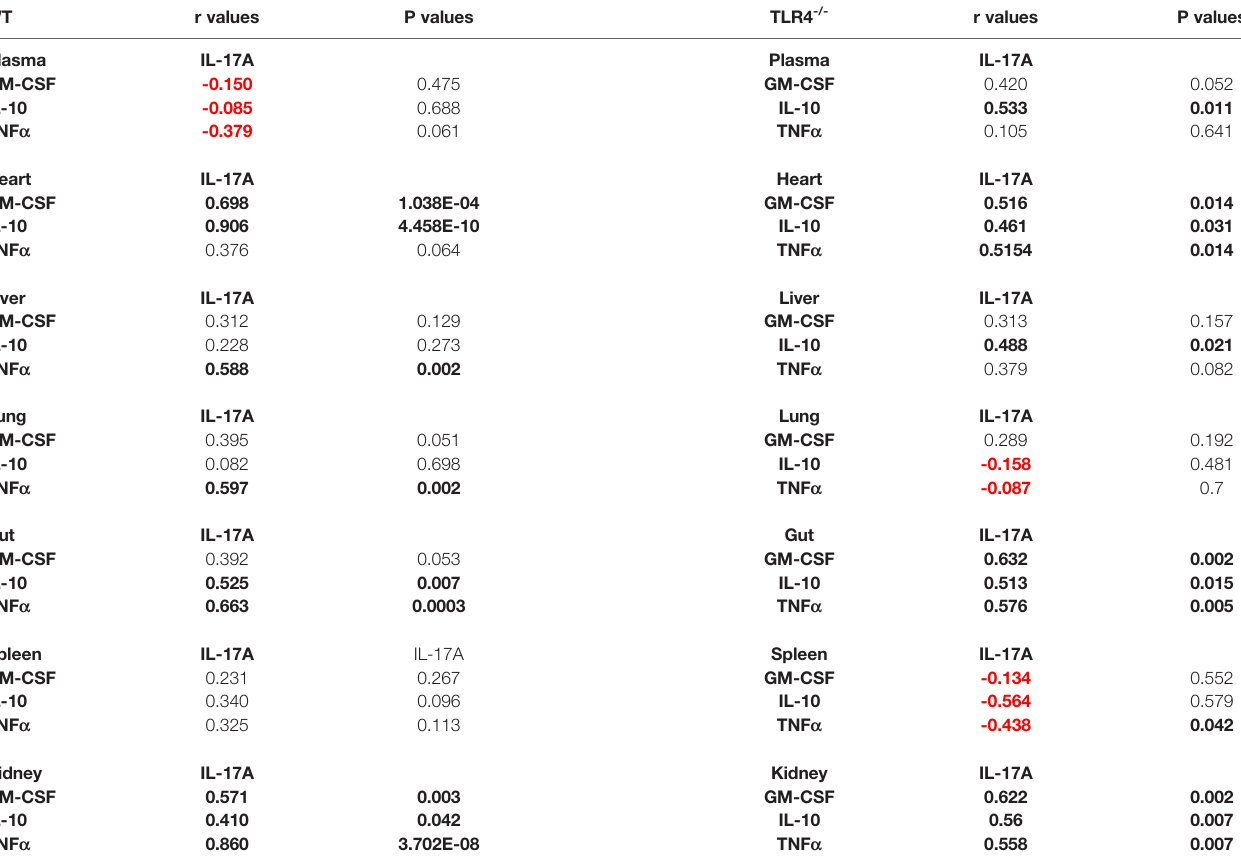
TABLE 1 | Spearman Rank Correlations (IL-17A vs. GM-CSF, IL-10 and TNFa) in WT and TLR4-/- mice. WT r values